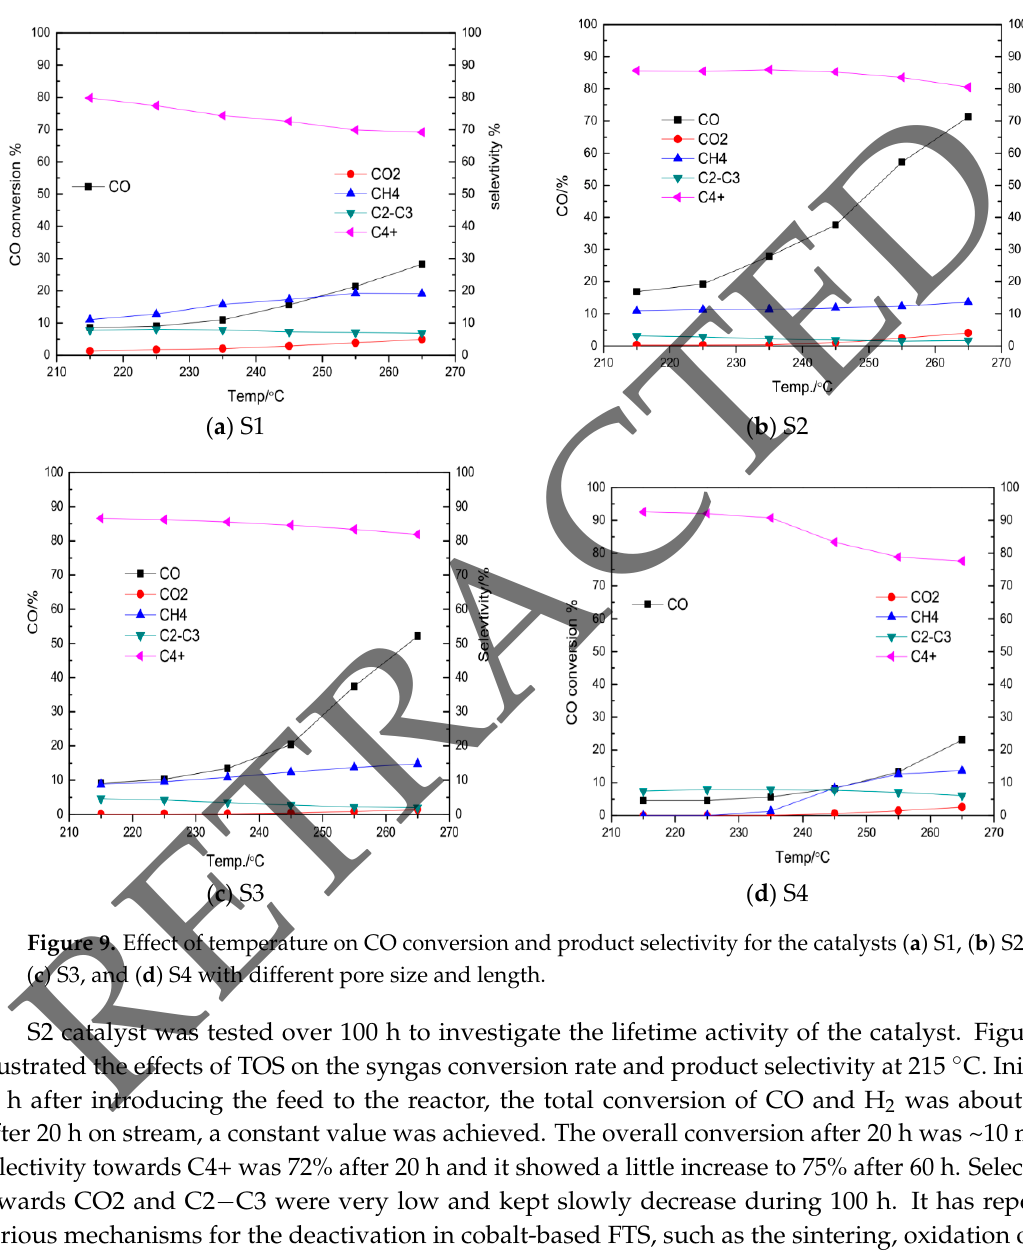
Figure 9. Effect of temperature on CO conversion and product selectivity for the catalysts ( a ) S1, ( b ) S2, ( c ) S3, and ( d ) S4 with different pore size and length.